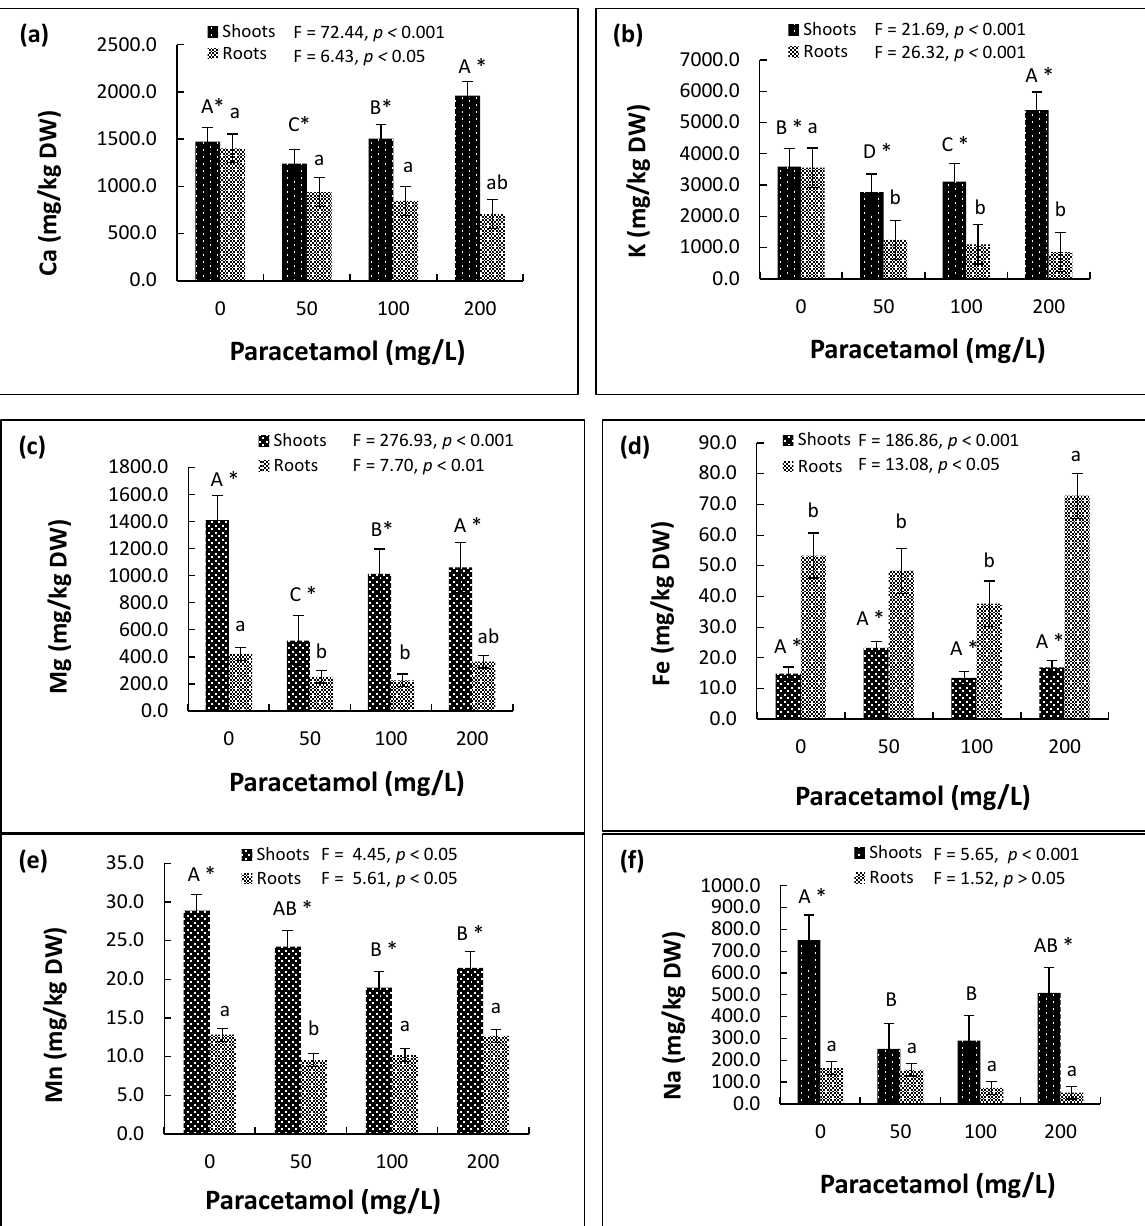
Figure 4. Effects of different paracetamol treatments on concentrations (mg/kg DW) of ( a – c ) macronutrients, ( d,e ) micronutrients and ( f ) sodium in shoot and root systems of spinach. Error bars represent means ± S.E. of three biological replicates. Means with different upper-case and lower-case letters indicate significant differences ( p ≤ 0.05 ) in nutrient and sodium concentrations between shoots and roots, respectively, at the different paracetamol treatments. Asterisks (*) indicate significant differences ( p ≤ 0.05 ) in the concentration of a nutrient or sodium between shoots and roots at a certain paracetamol level.